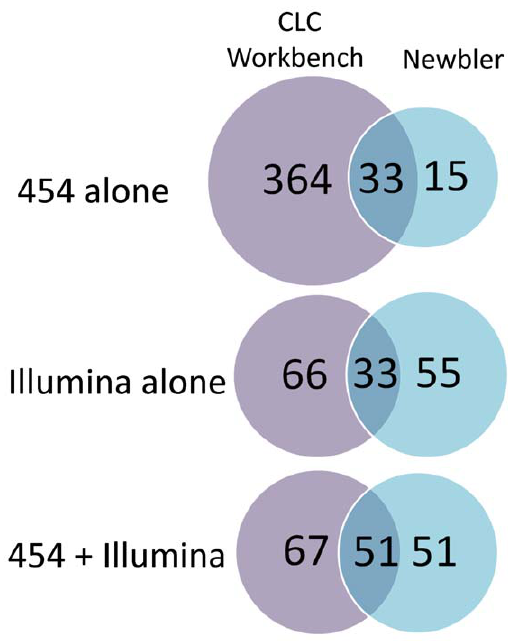
Figure 1. Comparison of SNP and INDELs detection tools based on different sequence assemblies. Assemblies of KIM D27 sequences from either 454 only, Illumina only, or hybrid assemblies (454 + Illumina) were analyzed for SNPs and INDELs as described in Materials and Methods. The Venn diagram represents the number of identified differences in either CLC Genomics Workbench or Newbler either singly (purple or blue, respectively) or the overlap between both programs (darkened area).